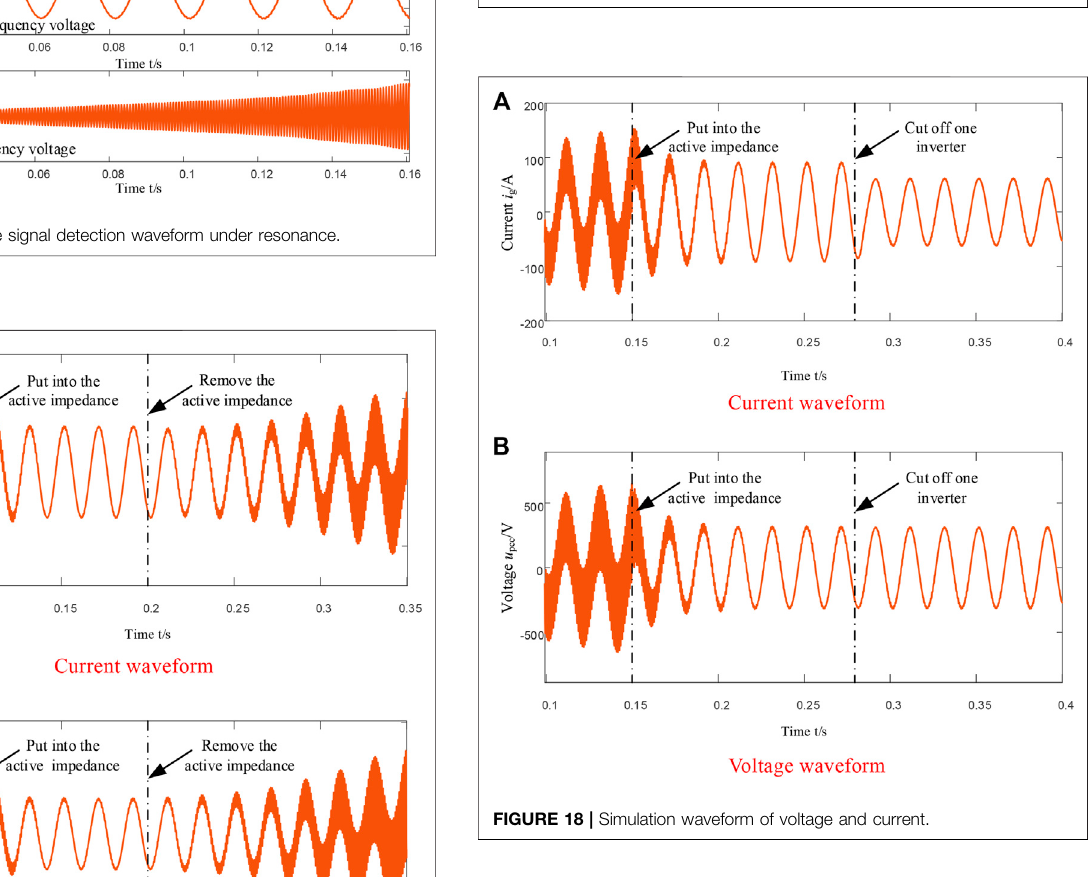
FIGURE 17 | Harmonic analysis of grid-connected current.